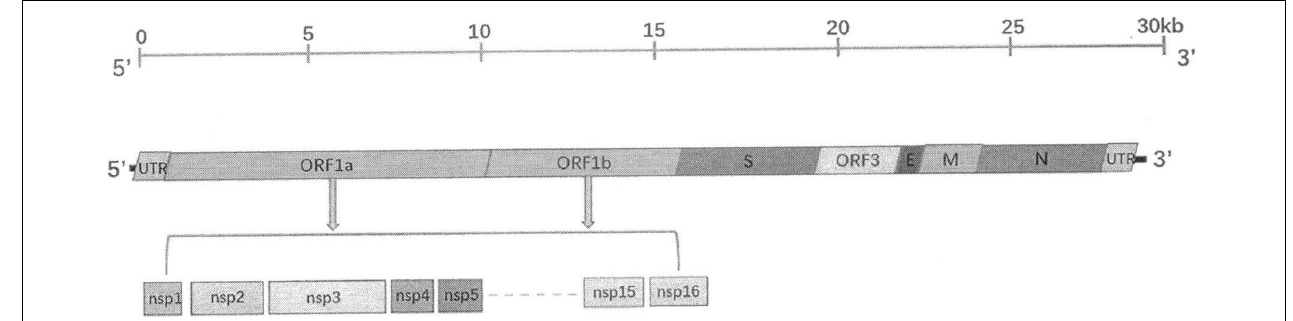
FIGURE 1 | Genomic structure of PEDV. PEDV is an enveloped virus with a single-stranded positive-sense RNA genome of 28 kb in length. 5 (cid:48) UTR and 3 (cid:48) UTR are indicated as shortened gray boxes; ORF1a and ORF1b encode replicase 1a and 1b, respectively, which are the two polyprotein precursors of 16 non-structural proteins. The genes encoding four structural proteins spike (S), envelope (E), membrane (M), and nucleocapsid (N) are shown as orange, red, green, and dark blue boxes, respectively. The gene encoding ORF3 is shown as a yellow